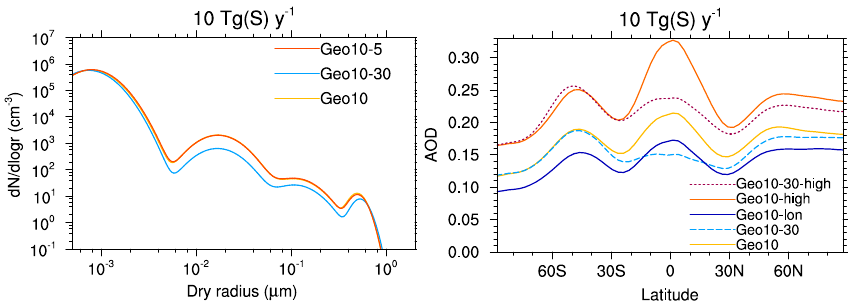
Figure 5. (Left) Aerosol number size distribution as in Fig. 4, but for the meridionally extended regions (Geo10-5, Geo10-30) and (right) zonally averaged data of AOD for experiments with injection rates of 10Tg ( S ) yr − 1 and varying extent of the injection area in zonal (Geo10- lon) and meridional (Geo10-5, Geo10-30) directions, and increasing injection level (Geo10-high,